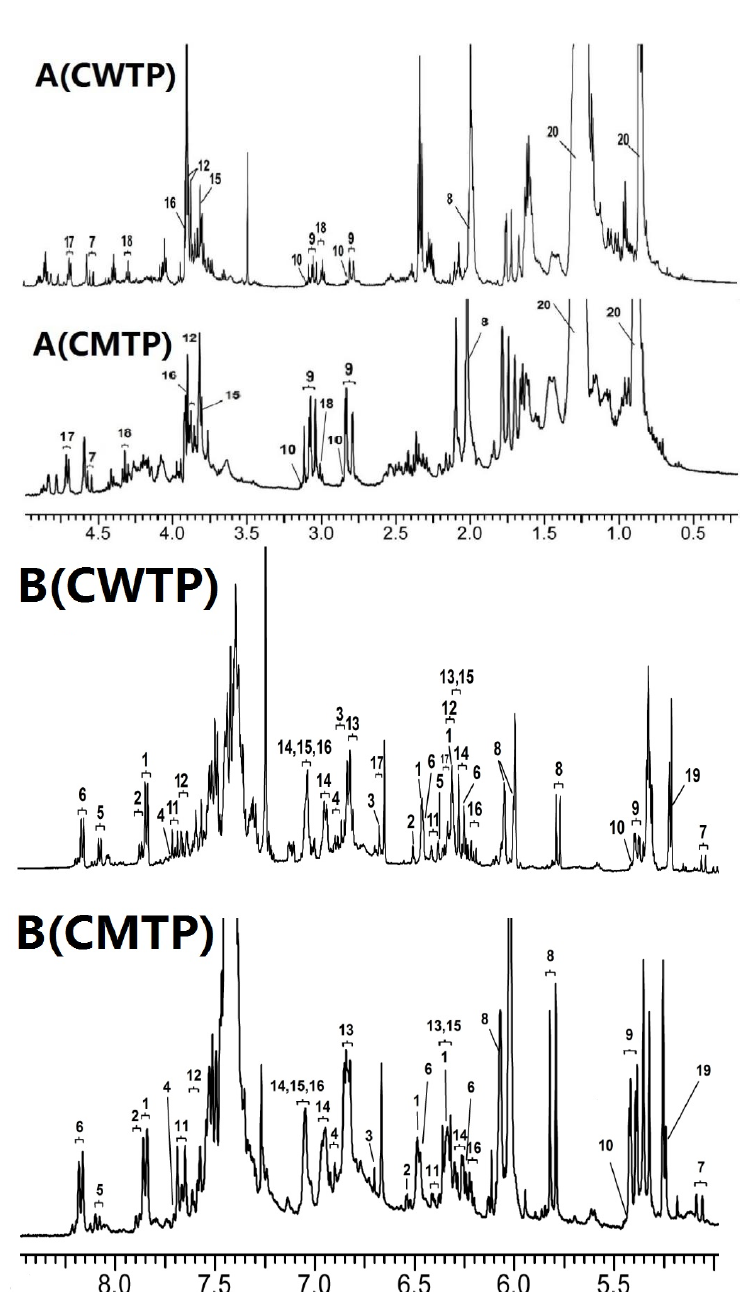
Figure 3. Typical 600 MHz 1 H NMR spectra of ethanol extract of Chinese warm temperate propolis (CWTP) and Chinese mid-temperate propolis (CMTP). The chemical compositions are assigned and labeled with the numbers in Table S1. The spectrum is cut into two spectral regions: A (upfield, 0.20–5.00 ppm); B (downfield, 5.00–8.80 ppm).